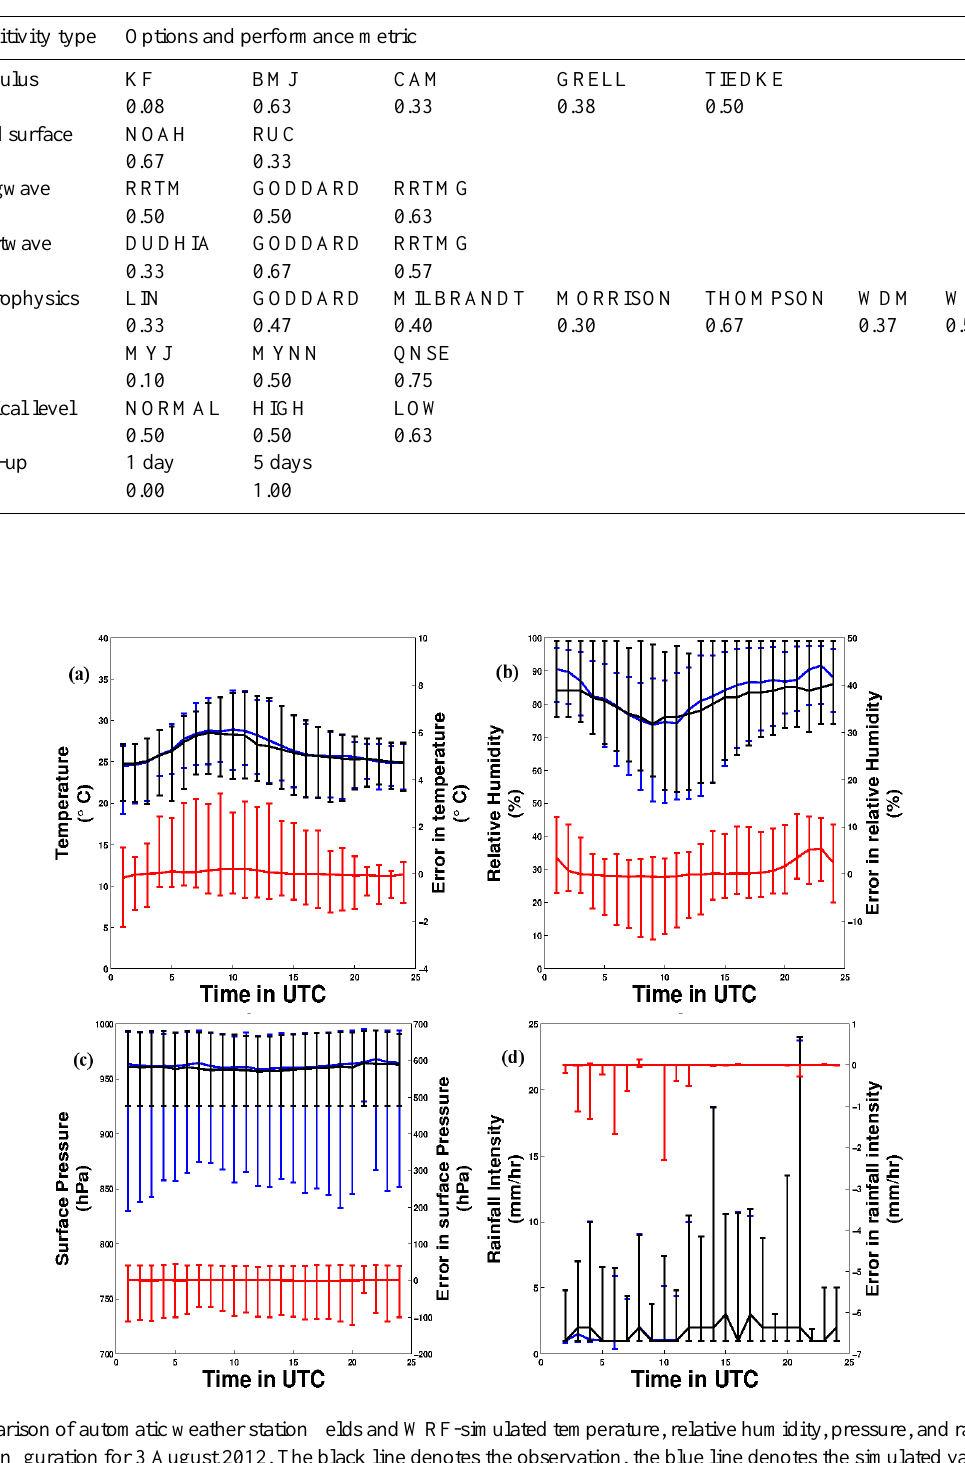
Table 3. The performances of different options in WRF simulation for Uttarkashi cloudburst.